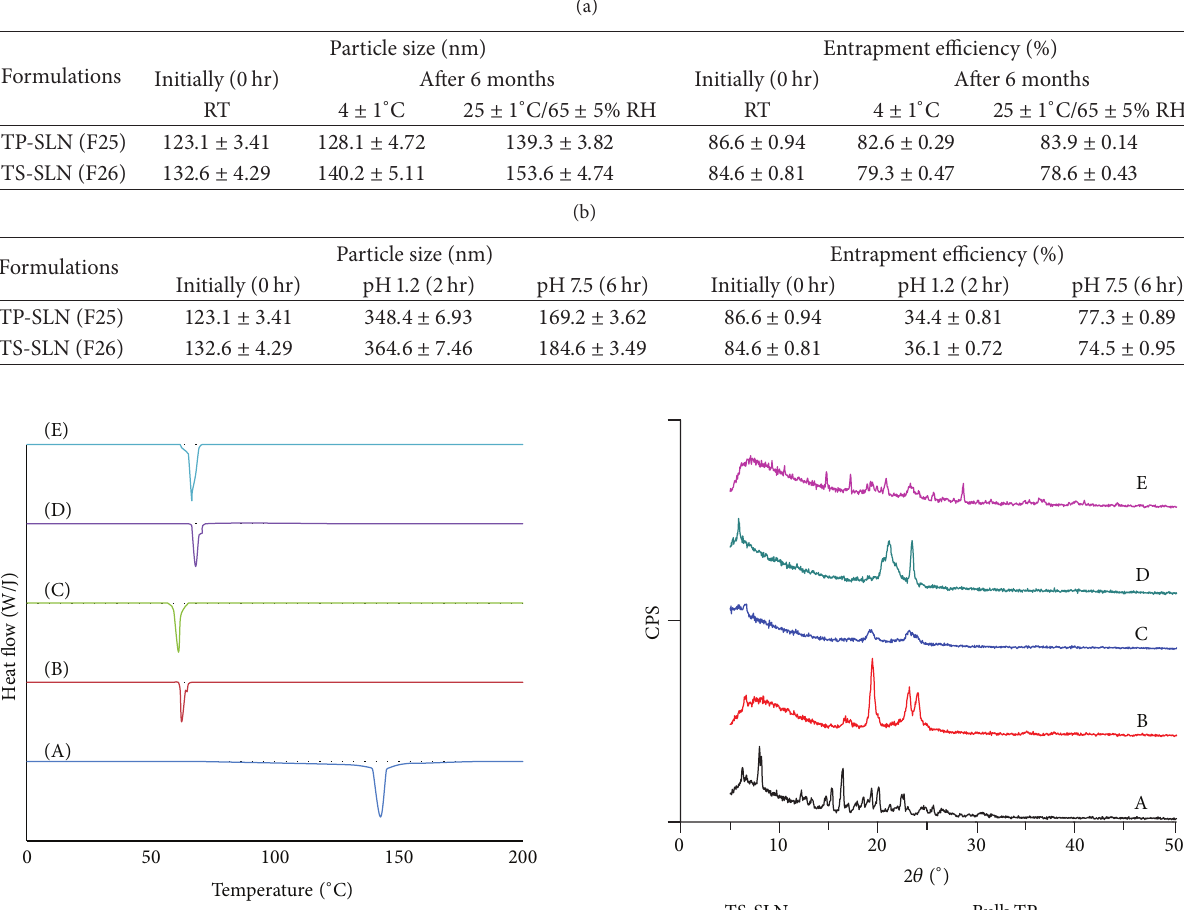
Table 3: (a) Particle size and entrapment efficiency of the PZQ-loaded SLN after storage at refrigerated temperature ( 4 ± 1 ∘ C) and at 25 ± 1 ∘ C/ 65 ± 5 % RH (values are reported as mean ± SD, 𝑛 = 4 ). (b) Particle size and entrapment efficiency of the PZQ-loaded SLN after storage at different pH conditions (values are reported as mean ± SD, 𝑛 = 4 ).